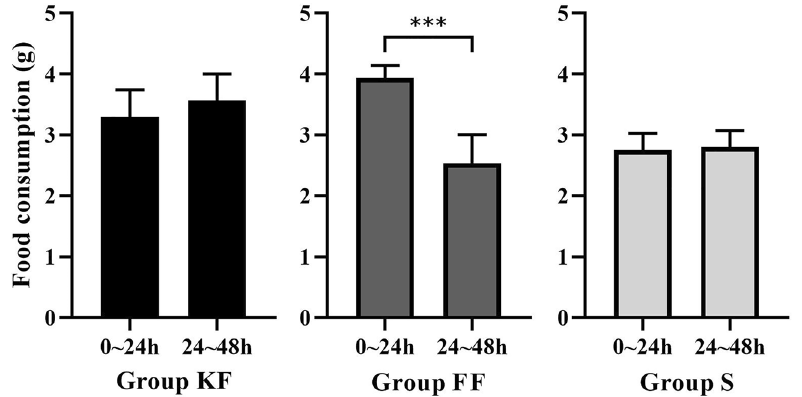
Figure 2. Food consumption of Apostichopus japonicus fed fresh food and food aged for 24 h for the three groups (mean ± SD, N = 8). KF, FF, S refer to group KF (consume the feces of sea urchins fed kelp), group FF (consume the feces of sea urchins fed prepared feed) and group S (consume the sea cucumber feed). The asterisk ***means P < 0.001.